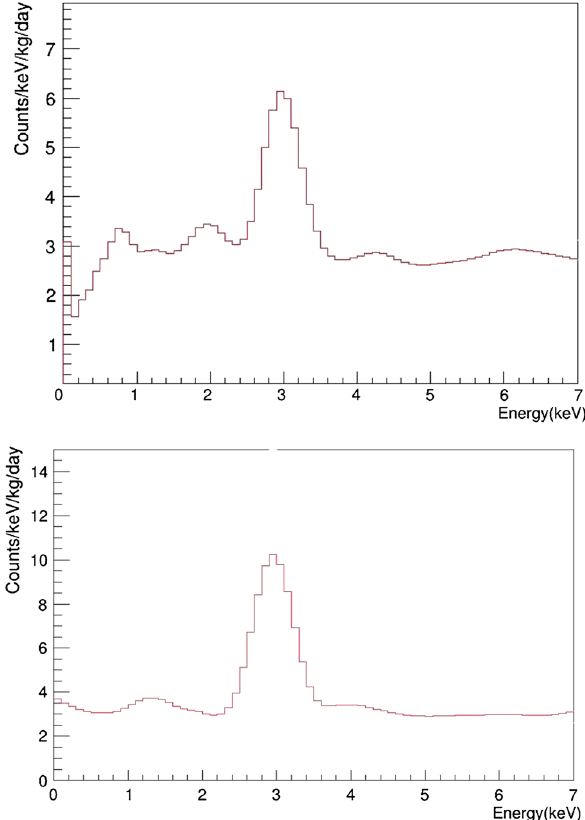
Fig. 7 Background spectra in the low energy region for Ar (top) and Ne (bottom) mixtures in TREX-DM, simulated for the dominant quan- tified internal activities: 40 K from the readout planes and cosmogenic 60 Co from the copper vessel. The experimental energy resolution of